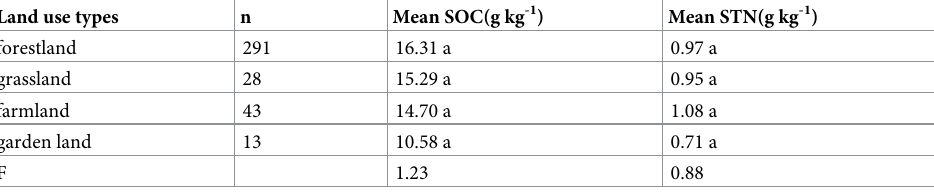
Table 7. Statistical results of the topsoil SOC and STN concentrations under different land use